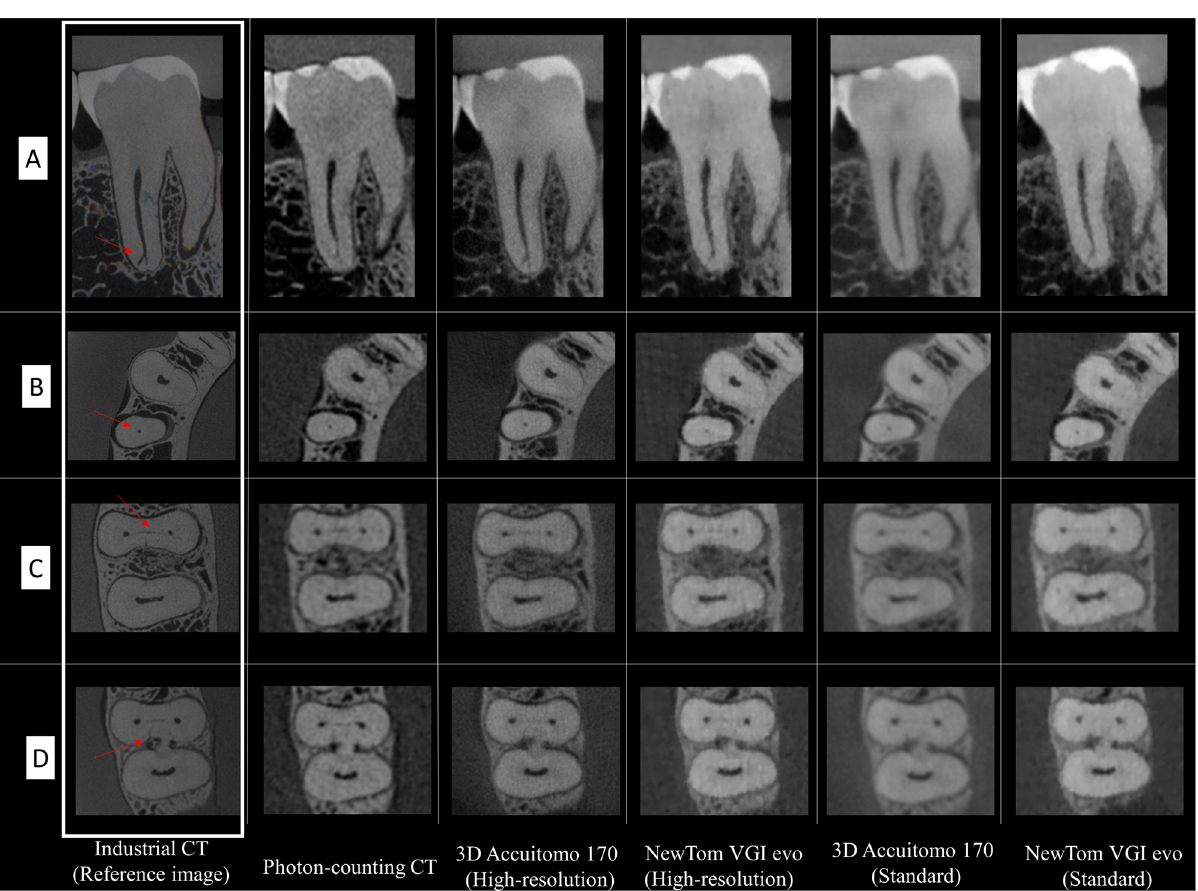
Figure 2. Representative imaging reconstructions of each diagnostic condition (as indicated by the arrows in the set of images of the Industrial CT—reference image) according to the different imaging modalities